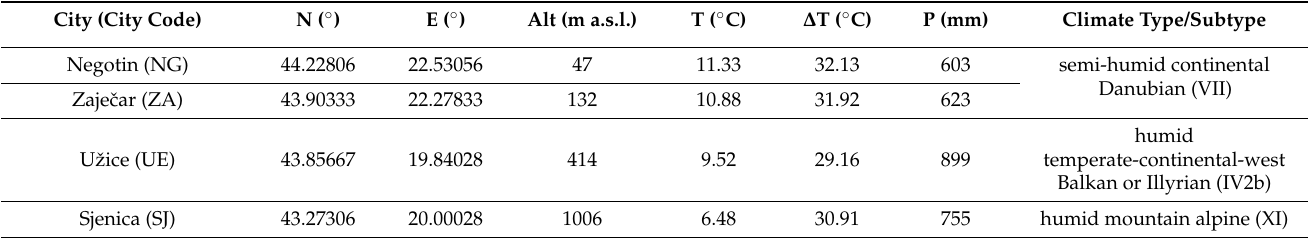
Table 3. Total explained variation, the influence of habitat type, climate, and their shared effect on the plant species composition in the analyzed